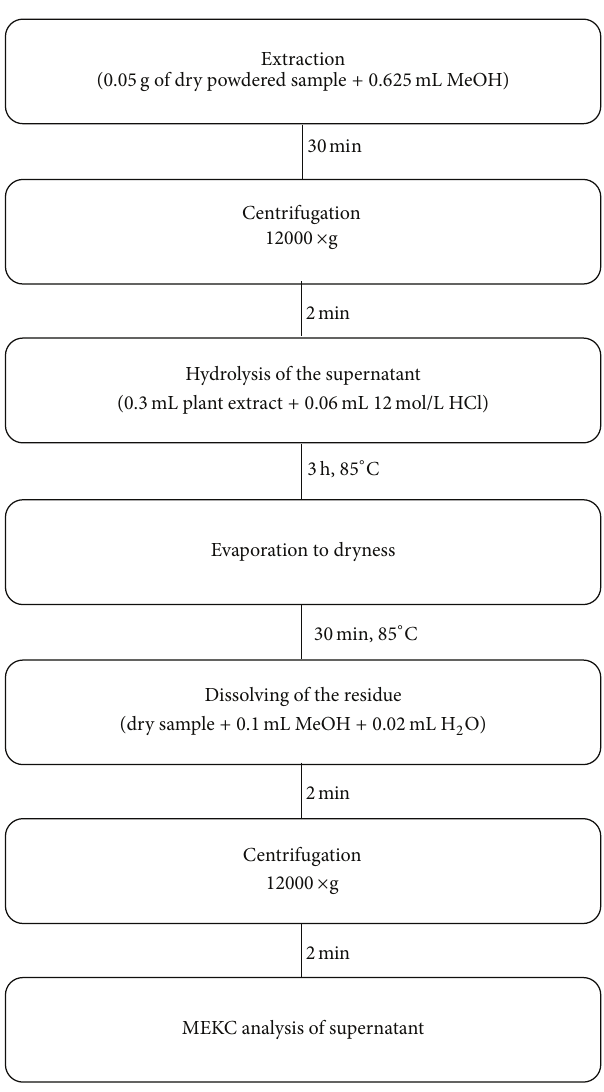
Figure 2: A flowchart diagram of sample